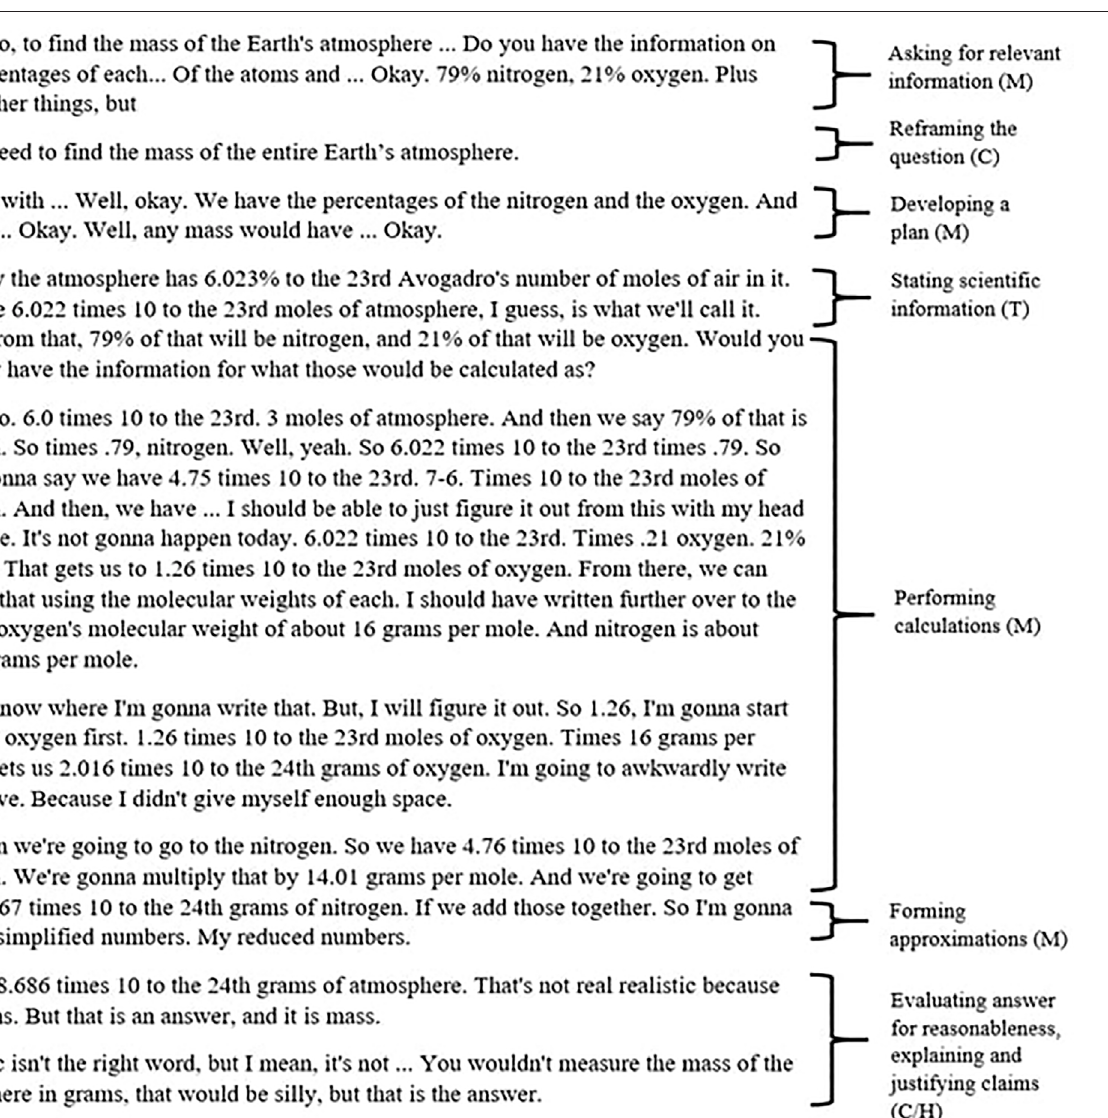
FIGURE 4 | Student excerpt of problem-solving (participant 4, question 3) to demonstrate the connections between MAtCH components and their effects on promoting problem-solving.